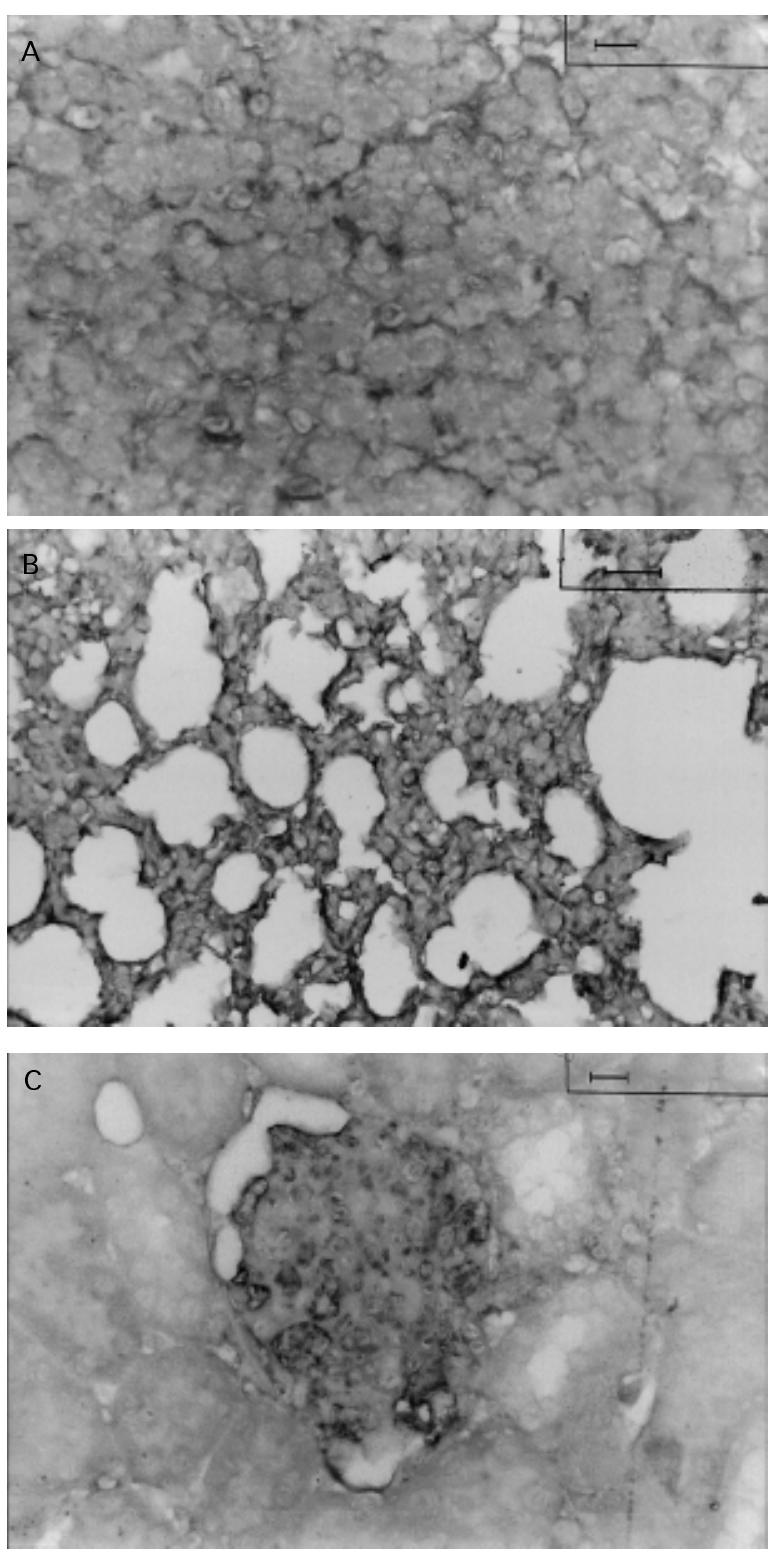
Figure 1 - Detection of IgG deposits in the liver, lung and kidney of hamsters infected with 2 x 10 7 amasti- gotes of Leishmania ( L. ) chagasi by immunoperoxidase staining using biotinylated goat anti-hamster IgG anti- body. A , IgG deposits along the sinusoid are seen in the liver of infected hamsters at 45 days of infection. B , IgG deposits in the capillary wall of the lung septum from infected animals at 30 days of infection. C , IgG depos- its outlining the capillary wall in the glomeruli of in- fected hamsters at 45 days of infection. Bar: 25